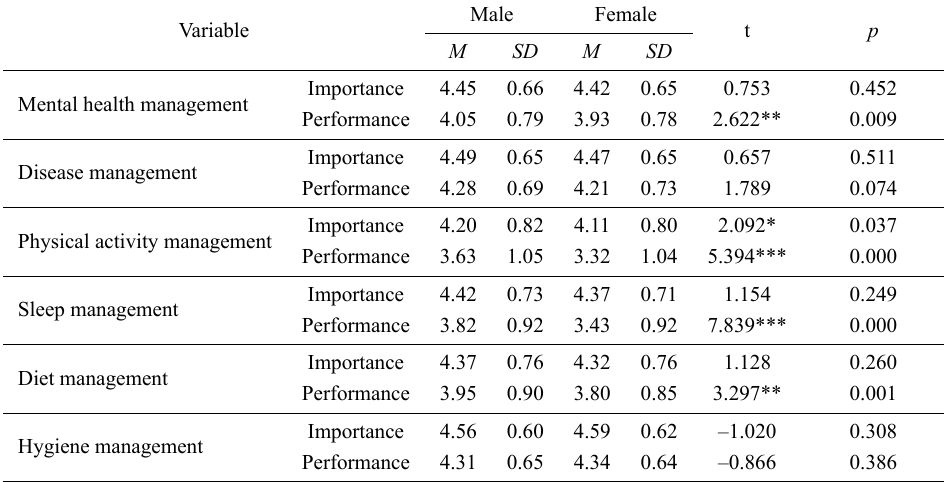
Table 4. Importance and performance comparisons between male and female adolescents.